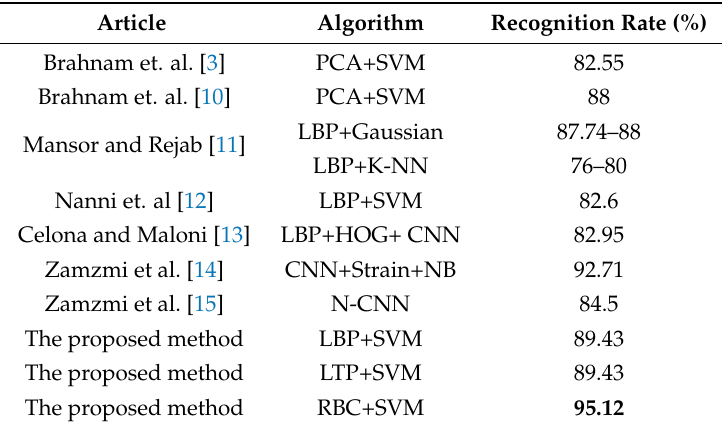
Table 2. Comparison with other